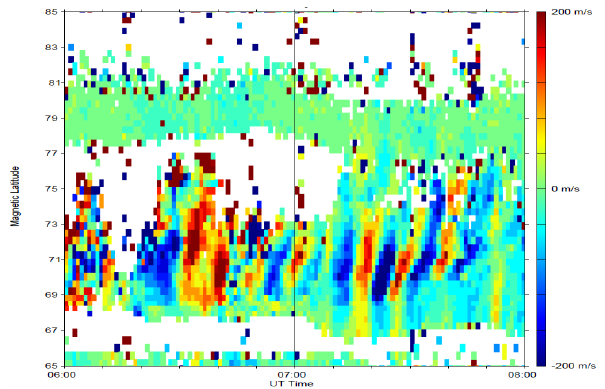
Fig. 2. The amplitude spectra of the line-of-sight Doppler velocity calculated using Goose Bay data collected on the 11 November 2002 from beam 2. The frequency resolution is 0.14 mHz and the red line indicates a resonance latitude.